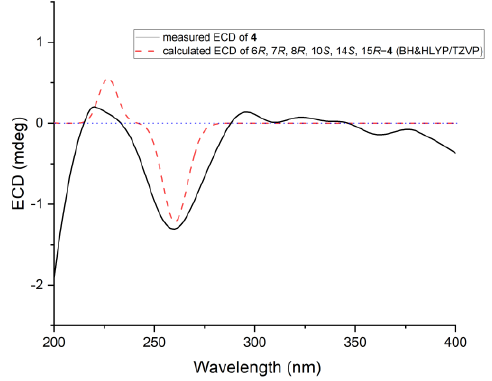
Figure 6. Experimental and calculated ECD of compound 4 . Compound 5 was obtained as a white amorphous powder, and the molecular formula was assigned as C 19 H 28 O 4 by HRESIMS data. Detailed analysis of the 1 H and 13 C data (Table 2) showed that it was similar to tanzawaic acid U [17] except that resonances for the methine unit at δ C 32.3 and δ H 1.46 (CH-10) in tanzawaic acid U were replaced by an oxygenated/nonprotonated carbon at δ C 68.0 (C-10) in 5 . These observations were further supported by relevant COSY and HMBC correlations (Figure 2). The coupling constants of two double bonds at C-2 and C-4 were 15.2 and 15.3 Hz, respectively, suggesting E - geometry for the double bonds. NOE correlations from H-5 to H-7 and H 3 -17, as well as from H 3 -17 to H 3 -18, indicated the same orientation of these protons, while correlations from H-6 to H-12 and H-13 showed them on the opposite side. The absolute configuration of 5 was determined by both ECD calculation and comparisons with known compounds 9 and 10 . The experimental ECD spectrum of 5 aptly matched the calculated spectra of (6 R , 7 R , 8 R , 10 R , 12 S , 13 S )- 5 at BH&HLYP/TZVP, CAM-B3LYP/TZVP, and PBE0/TZVP levels (Figures 7 and S59). Besides, 5 showed a positive Cotton effect at approximately 264 nm similar to that of compounds 9 and 10 (Figure 8), which also confirmed the absolute configuration of 5 . Compound 5 was named 10-hydroxytanzawaic acid U.